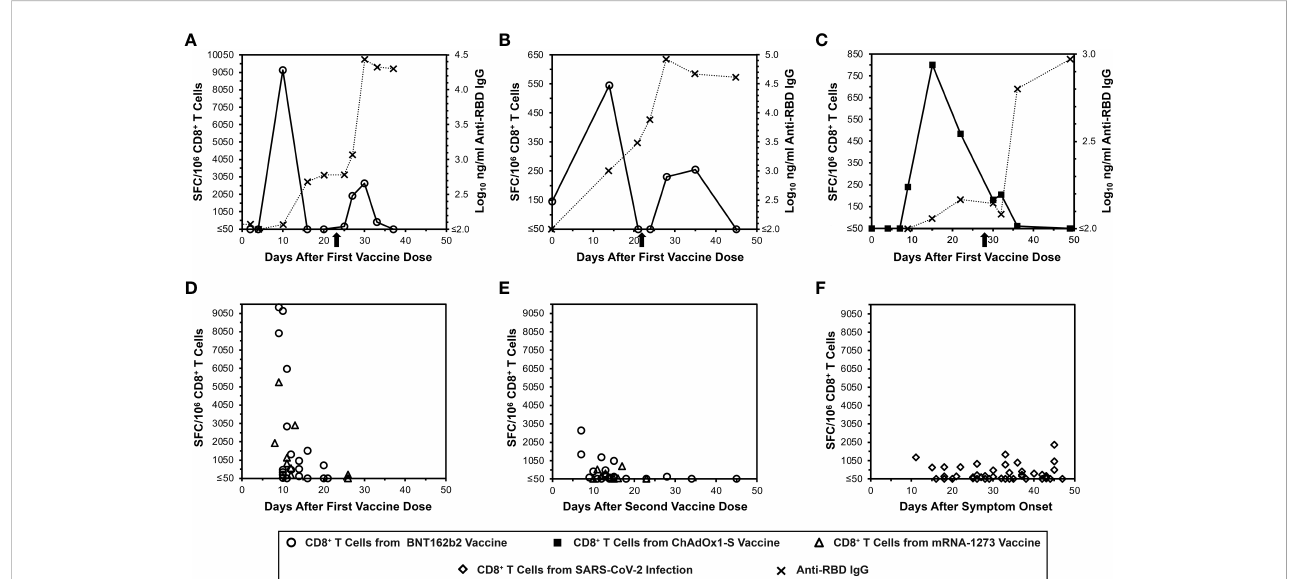
FIGURE 1 Transience of peripheral blood SARS-CoV-2 spike-speci fi c CD8+ T cells elicited by mRNA vaccination compared to natural infection, as assessed by IFN- g ELISpot. Spike-speci fi c CD8+ T cells were assayed by IFN- g ELISpot assay using pooled overlapping peptides. (A, B) Serial CD8+ T cell responsesc against spike (open circles) and IgG responses against the spike RBD (Xs) are plotted for two SARS-CoV-2-naïve persons who received the BNT162b2 vaccine. The X-axis starts with the fi rst vaccine dose, and the timing of the second dose is indicated by an arrow. (C) Serial CD8+ T cell responsesc against spike (closed squares) and IgG responses against the spike RBD (Xs) are plotted for a SARS-CoV-2-naïve person who received the ChAdOx1-S vaccine. The X-axis starts with the fi rst vaccine dose, and the timing of the second dose is indicated by an arrow. (D) CD8+ T cell spike-speci fi c responses are plotted for 25 persons who were SARS-CoV-2-naïve after the fi rst vaccine dose with BNT162b2 (16 persons, 20 data points, circles) or mRNA-1273 (9 persons, 9 data points, triangles). (E) CD8+ T cell spike-speci fi c responses are plotted for 24 persons who were SARS-CoV-2-naïve after the second vaccine dose with BNT162b2 (15 persons, 20 data points, circles) or mRNA-1273 (9 persons, 9 data points, triangles). (F) CD8+ T cell spike- speci fi c responses are plotted for 45 COVID-19-recovered persons according to time after symptom onset